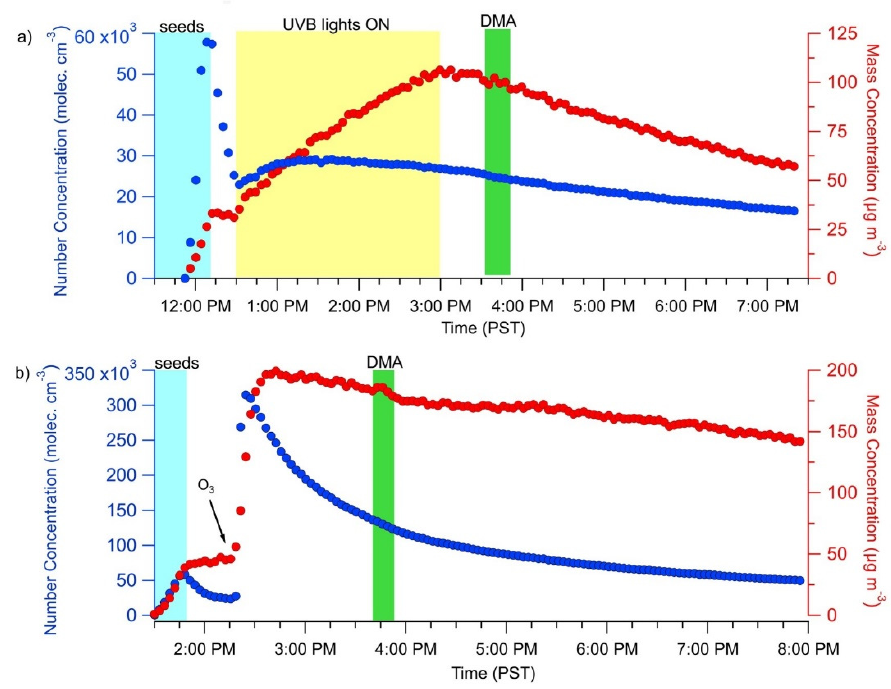
Figure 1. Summary Particle number concentration (blue trace, left Y-axis) and particle mass concen- tration (red trace, right Y-axis) for ( a ) TOL/OH SOA at low relative humidity and ( b ) LIM/O 3 SOA at low relative humidity. The blue shaded area corresponds to the addition of nicotinic seed particles, the yellow shaded area corresponds to photooxidation, and the green shaded area corresponds to the injection of